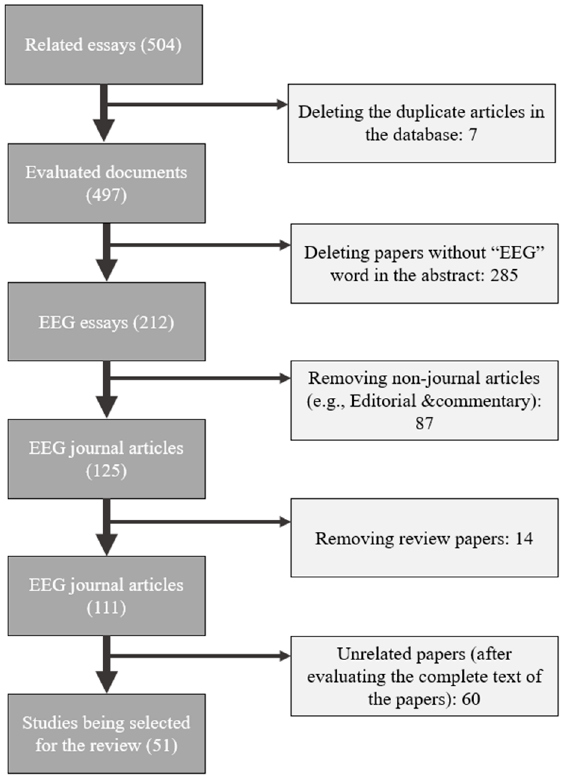
Figure 1. Flow chart of search strategy and identification of relevant studies.